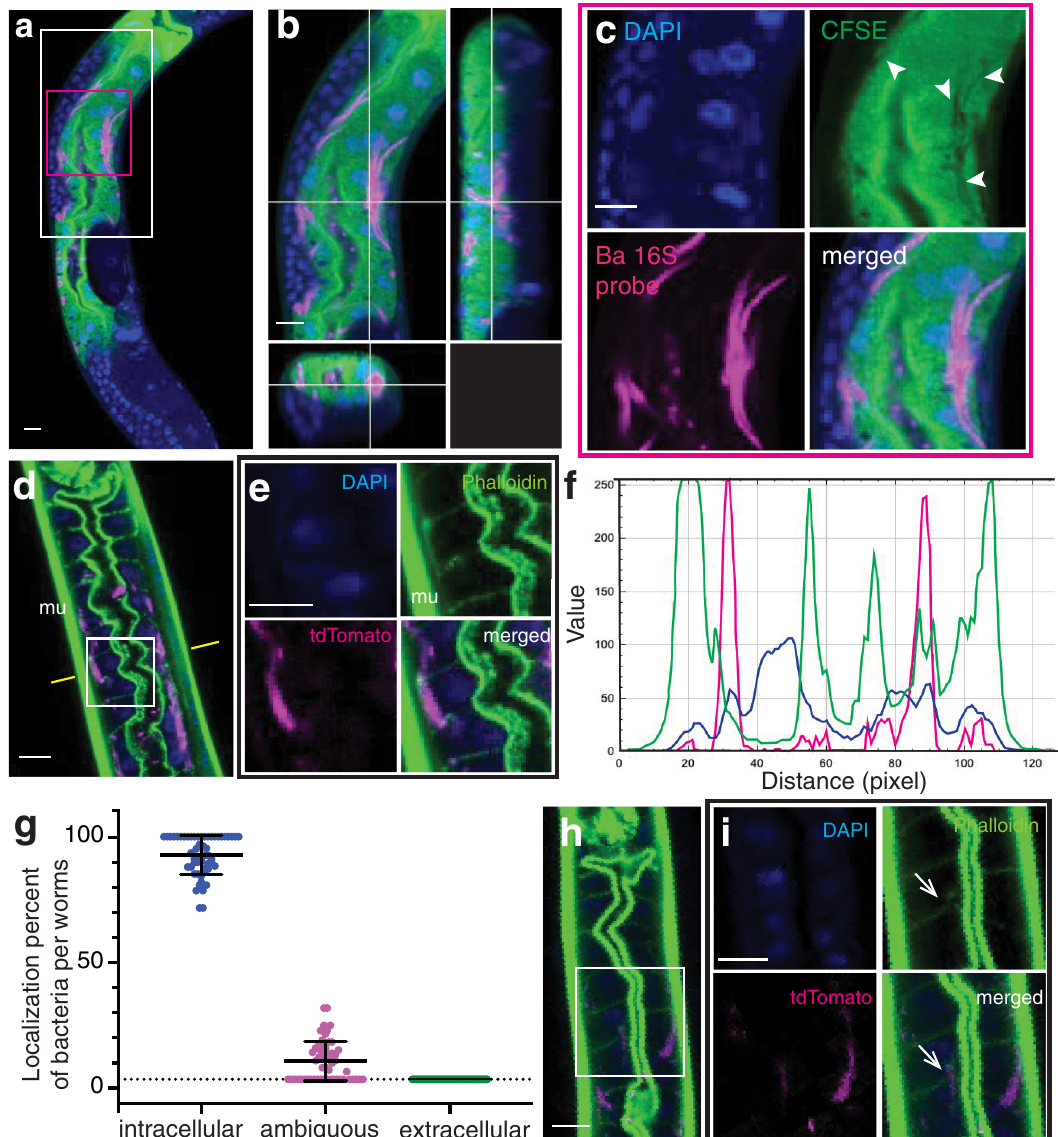
Fig. 3 B. atropi fi laments localize with intestinal intracellular staining. a Representative confocal image of FISH-stained animals infected with B. atropi and stained with the cytoplasmic dye, CFSE, which strongly stains the intestinal cell cytoplasm. b Orthogonal view of white-boxed region in a . c Higher magni fi cation of red-boxed region in a showing CFSE-cleared areas (white arrowheads) are overlapped by signals from 16S probe speci fi c-FISH to B. atropi . d Representative image of animals stained with phalloidin. e Higher magni fi cation of region indicated by white box in d showing B. atropi presence in intestinal cells outlined by basolateral and apical actin fi laments (mu, body wall muscle is indicated). f Line pro fi le analysis at the plane indicated by yellow lines in d showing localization of tdTomato ( B. atropi) in-between Alexa488-phalloidin (actin). g Quanti fi cation of bacterial localization from the experiment conducted in d , with a total of n = 60 animals containing N = 916 infection events analyzed in 2 independent experiments. Means are shown and error bars represent SD. h A phalloidin-stained animal with a fragment of fi lament pushing through intestinal lateral actin. i Inset indicated in h . Scale bars are 10 μ